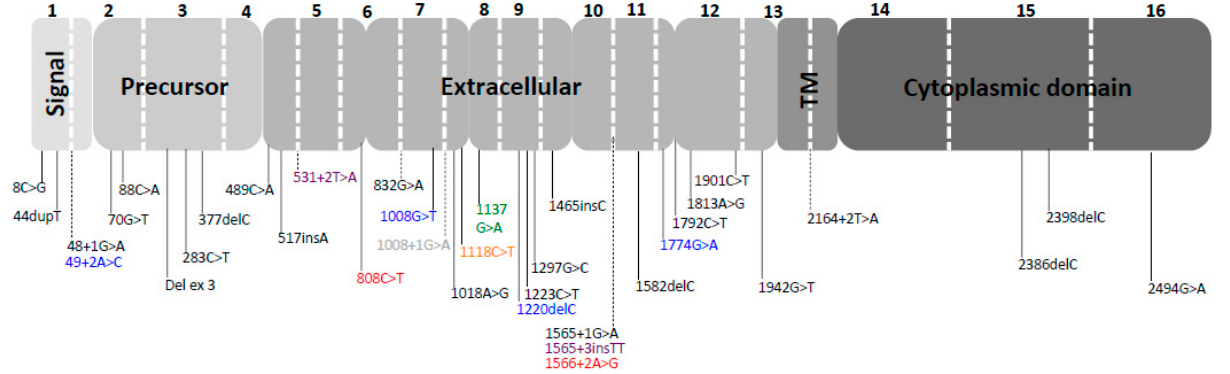
Figure 2. Mutation distribution in the different sites of CDH1 gene (SG: signal, TM: transmembrane, red: prostate cancer, black: breast cancer, orange: ovarian cancer, blue: colorectal cancer, purple: abdominal carcinosis, green: tongue cancer, and grey: thyroid cancer).